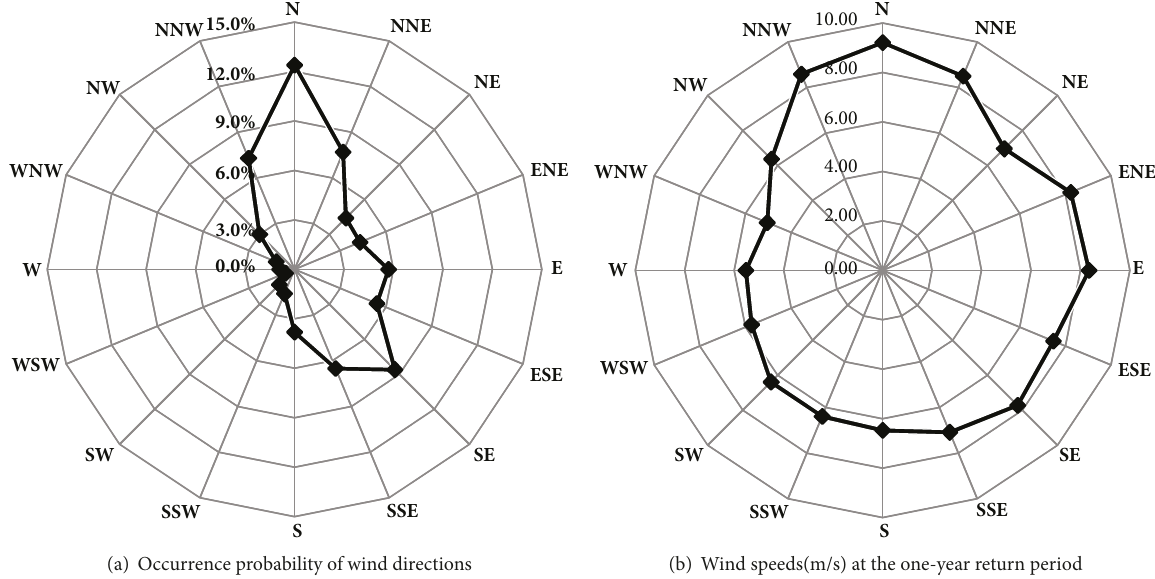
Figure 5: Occurrence probability of wind directions and speeds at a one-year return period under 16 wind directions in Guangzhou.